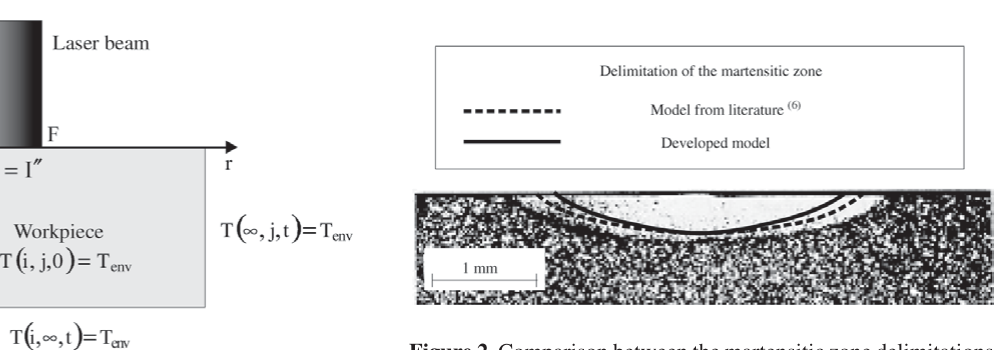
Figure 2 . Comparison between the martensitic zone delimitations by the developed model and the one calculated by the Bokota model 6